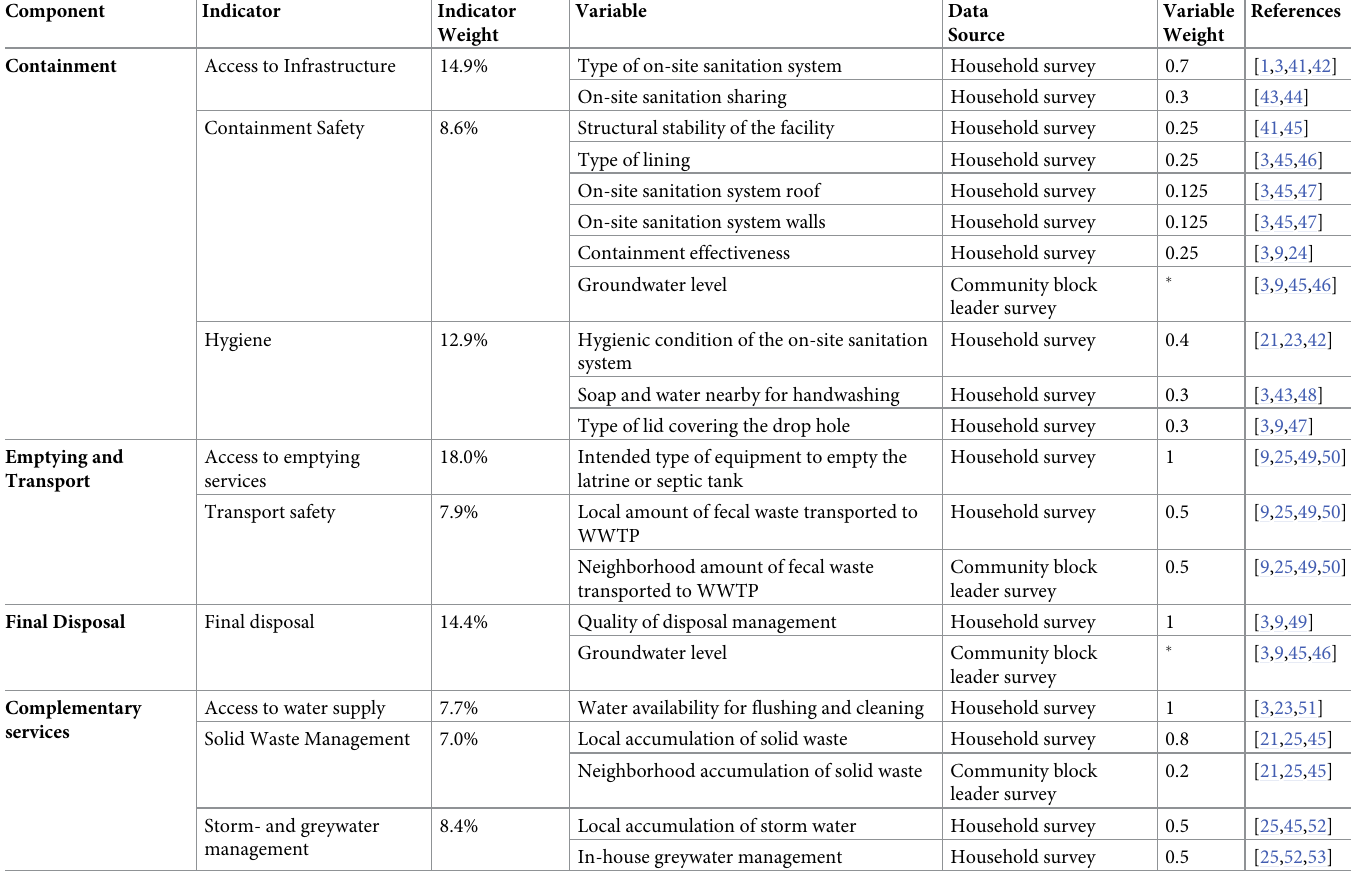
Table 1. LSSI/USSI